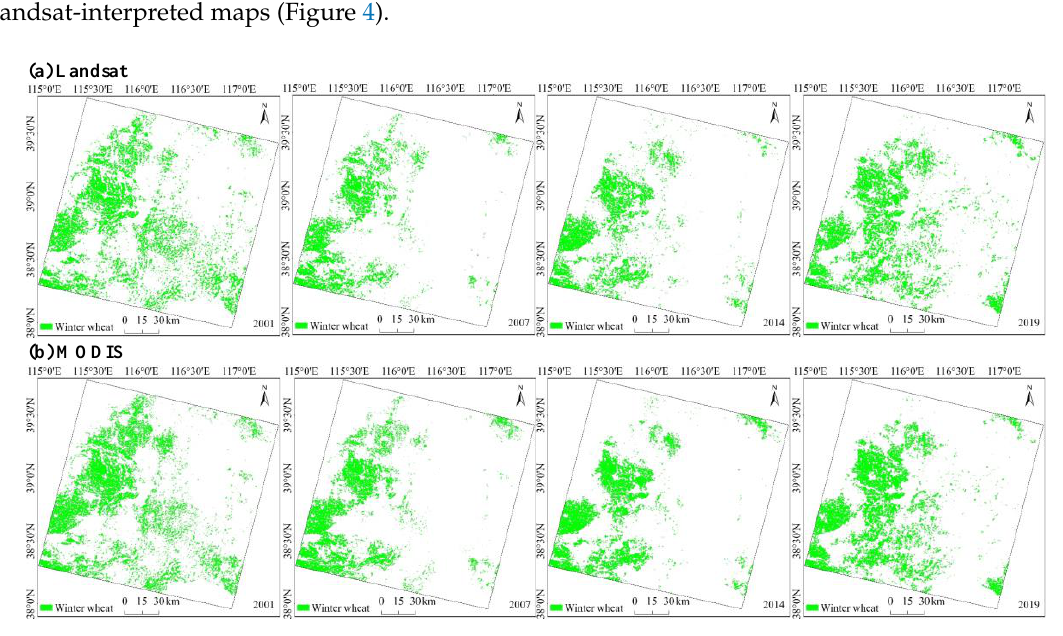
Table 2. Accuracy assessment using field survey data (sites) in 2019.